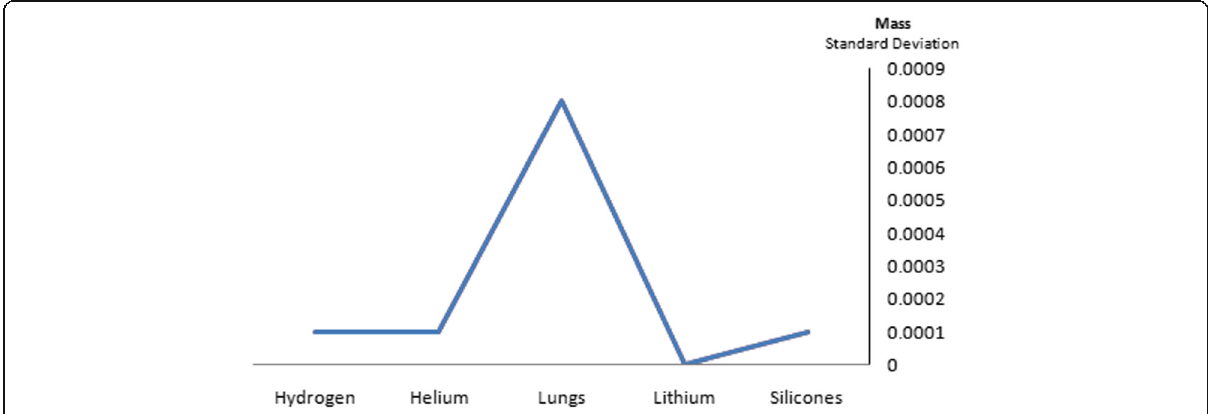
Fig. 13 The standard deviation of the mass for particles of silicones, lithium, lungs, helium, and hydrogen in one